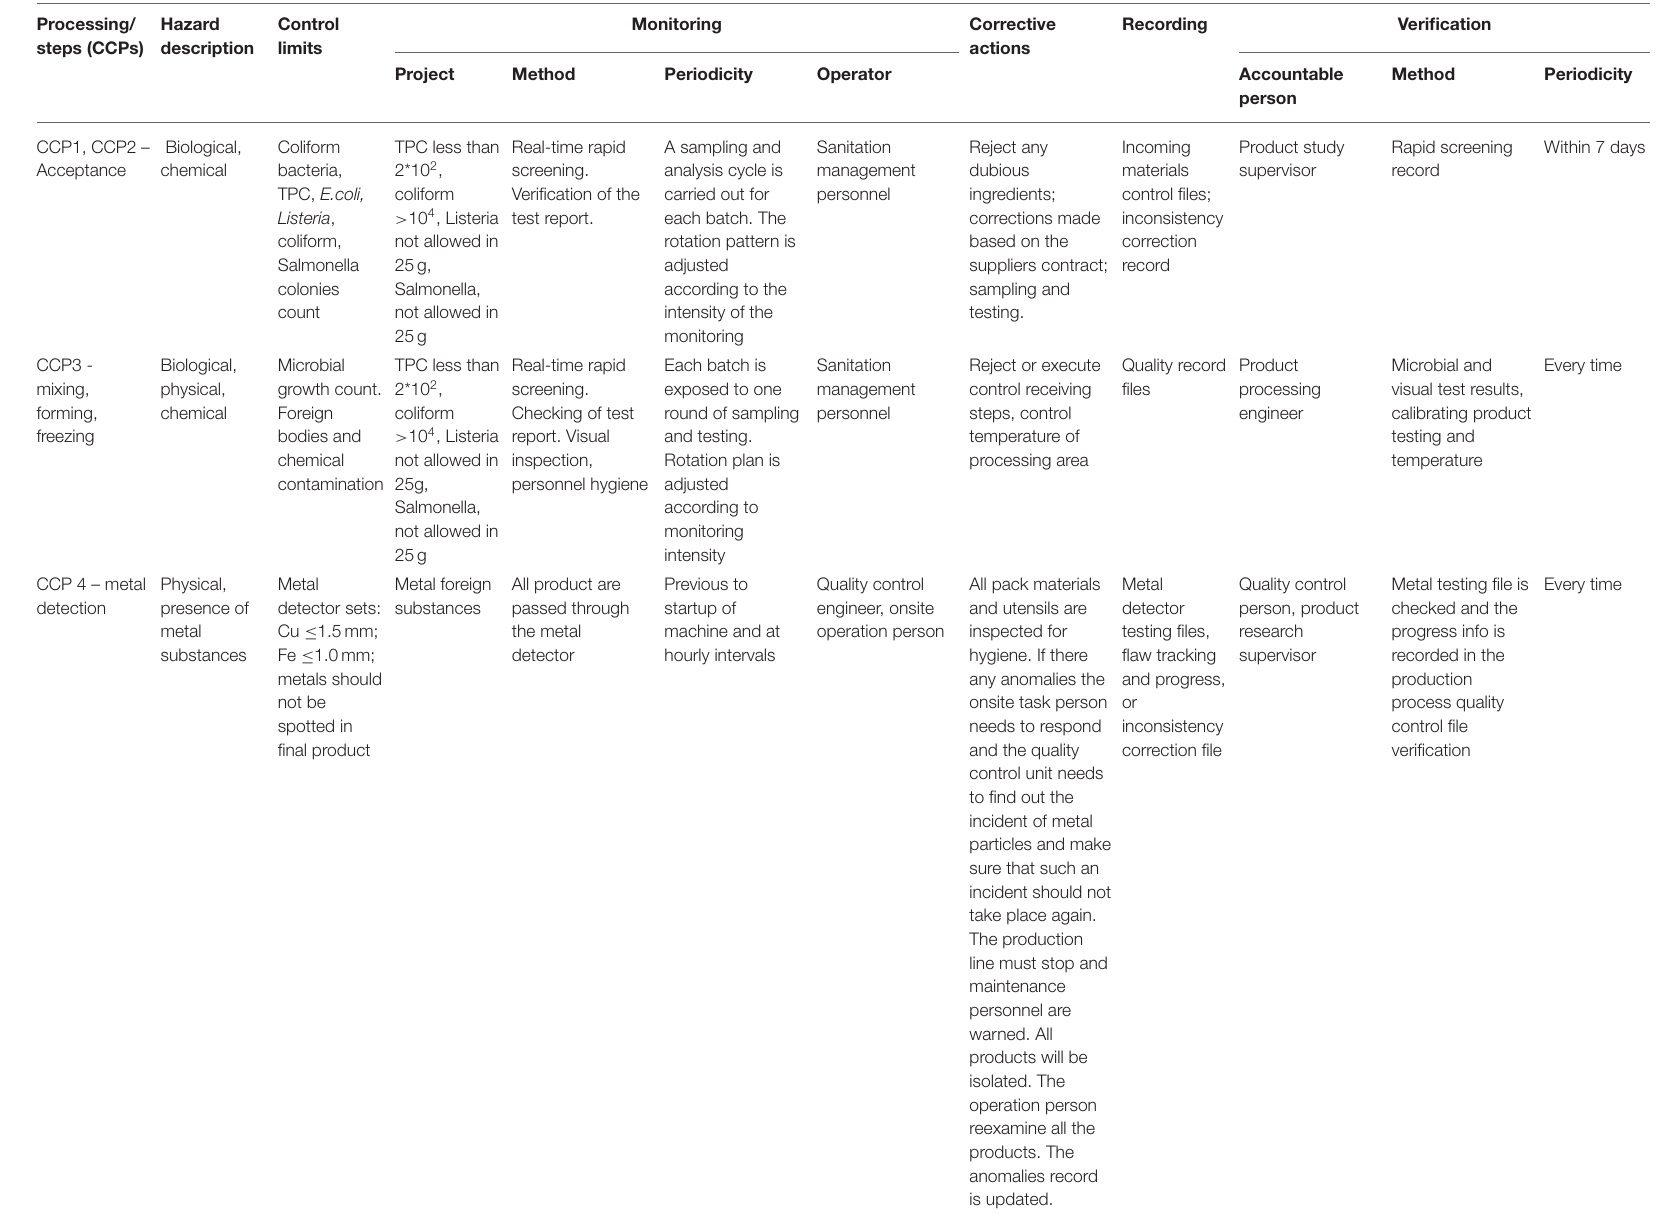
TABLE 4 | Hazard control plan (CCP plan) for production of patties “Shygys”. Processing/ Hazard Control steps (CCPs) description